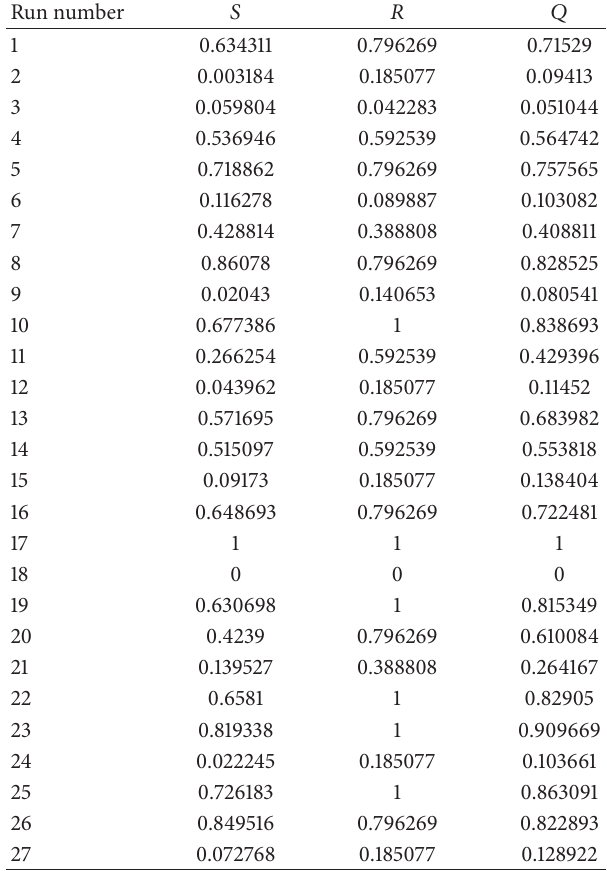
Table 9: Result of eigenvalues.